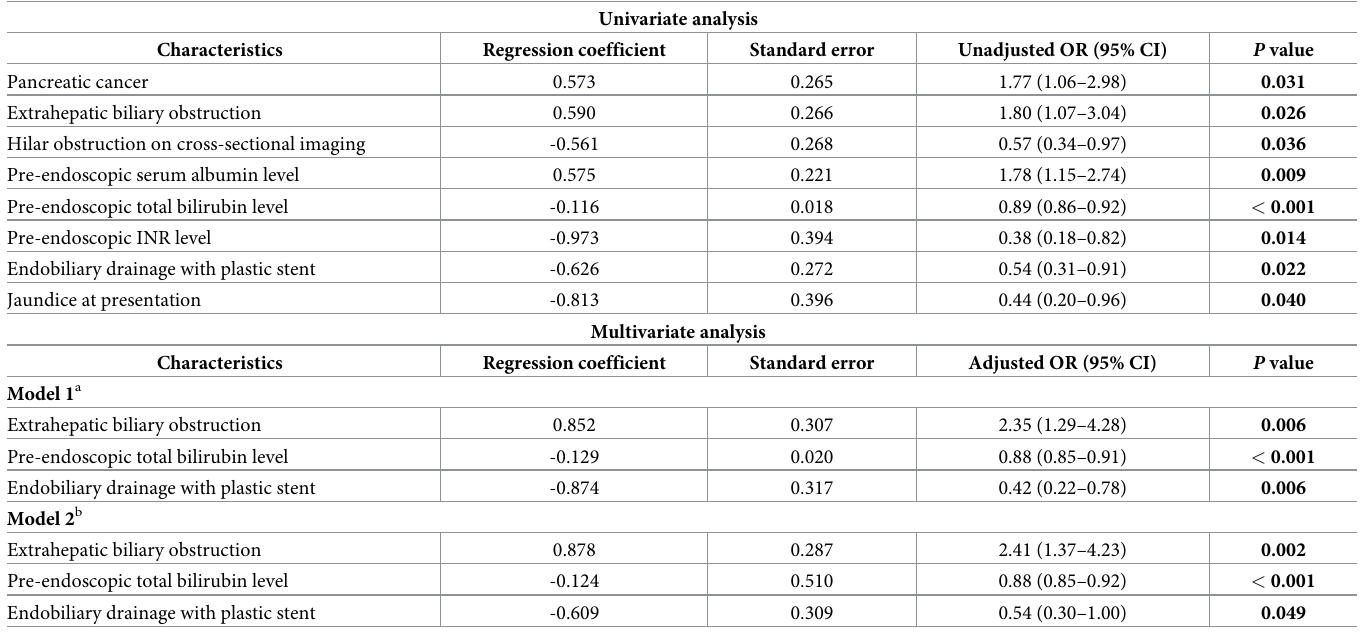
Table 3. Univariate and multivariate analysis of baseline variables for predicting bilirubin normalization within 6 weeks after stenting in the derivation cohort. Univariate